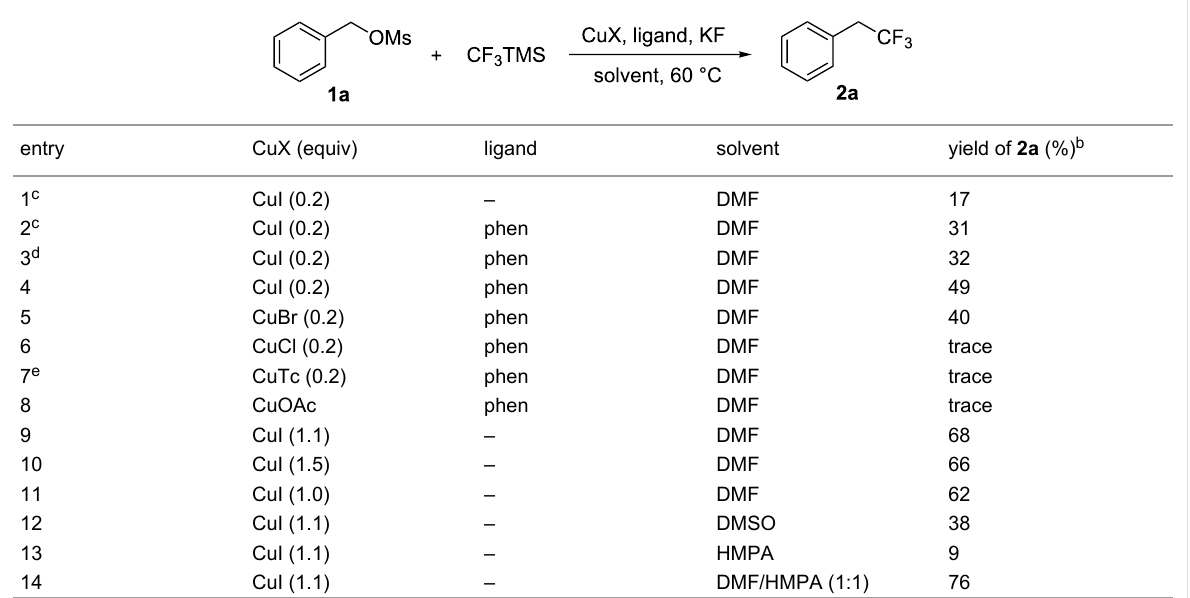
Table 1: Optimization of the reaction conditions.